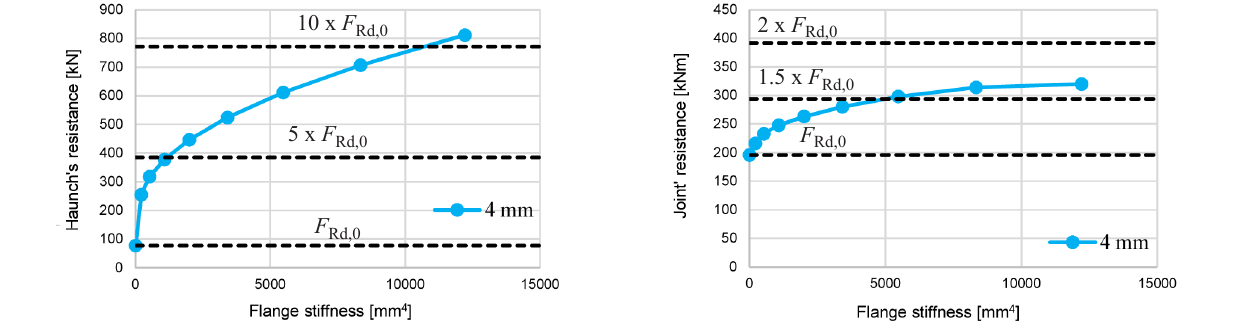
Fig. 17. Relation between resistance of the haunch and flange stiffness